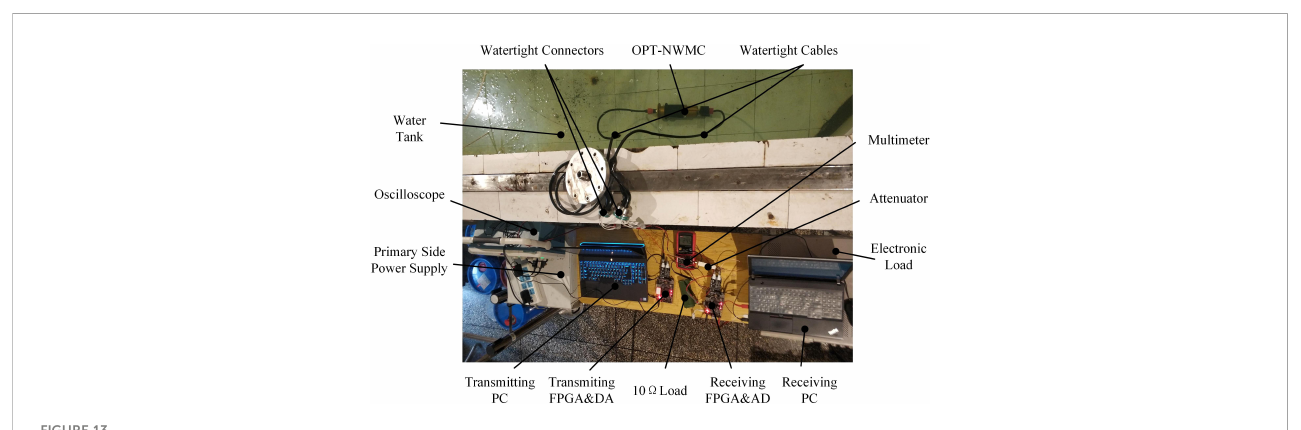
FIGURE 13 The con fi guration for the tool experiment of OCPT-NWMC.